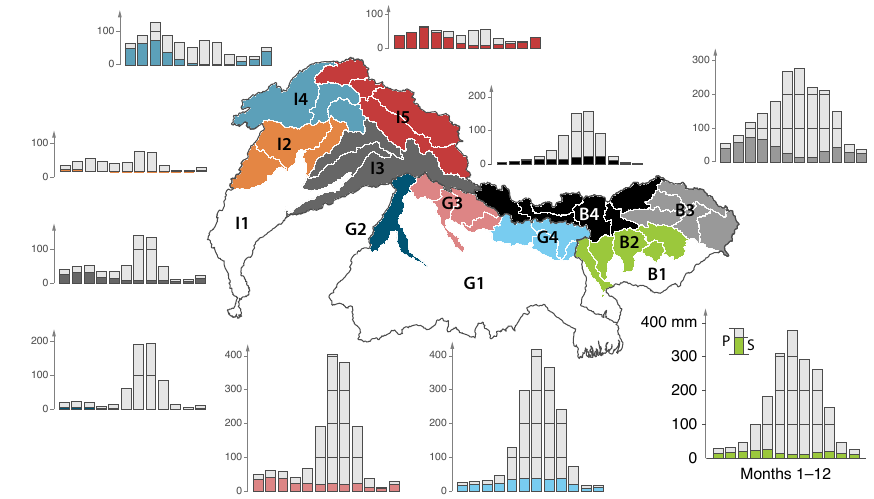
Figure 3. Monthly mean MERRA precipitation and MERRA reference snowfall in sub-basin clusters of the Indus (I), Ganges (G) and Brahmaputra (B). Total bar height: MERRA precipitation ( P ) (mm). Colored bars: snowfall ( S ) (mmSWE) based on MERRA precipitation and terrain-adjusted MERRA temperature, in the region with the same color. Cluster 1 in each basin is considered snow free, and the seasonal cycles are not shown. All subplots have the same